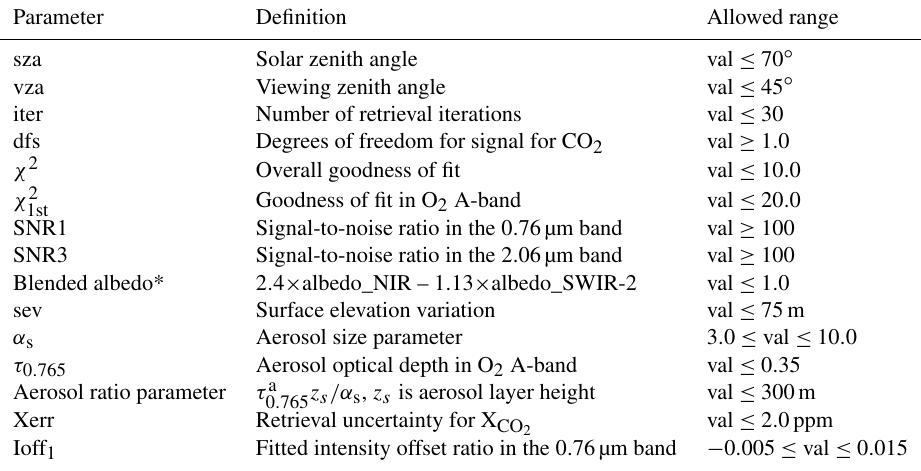
Table 2. Settings of the filters used for excluding low-quality XCO 2 retrievals in OCO-2 retrievals. Parameter Definition Allowed range sza Solar zenith angle val ≤ 70 ◦ vza Viewing zenith angle val ≤ 45 ◦ iter Number of retrieval iterations val ≤ 30 dfs Degrees of freedom for signal for CO 2 val ≥ 1 . 0 χ 2 Overall goodness of fit val ≤ 10 . 0 χ 2 Goodness of fit in O 2 A-band val ≤ 20 . 0 1st SNR1 Signal-to-noise ratio in the 0 . 76µm band val ≥ 100 SNR3 Signal-to-noise ratio in the 2 . 06µm band val ≥ 100 Blended albedo* 2 . 4 × albedo_NIR – 1 . 13 × albedo_SWIR-2 val ≤ 1 . 0 sev Surface elevation variation val ≤ 75m α s Aerosol size parameter 3 . 0 ≤ val ≤ 10 . 0 τ 0 . 765 Aerosol optical depth in O 2 A-band val ≤ 0 . 35 z s /α s , z s is aerosol layer height val ≤ 300m Aerosol ratio parameter τ a 0 . 765 Xerr Retrieval uncertainty for X CO val ≤ 2 . 0ppm 2 Ioff 1 Fitted intensity offset ratio in the 0 . 76µm band − 0 . 005 ≤ val ≤ 0 .